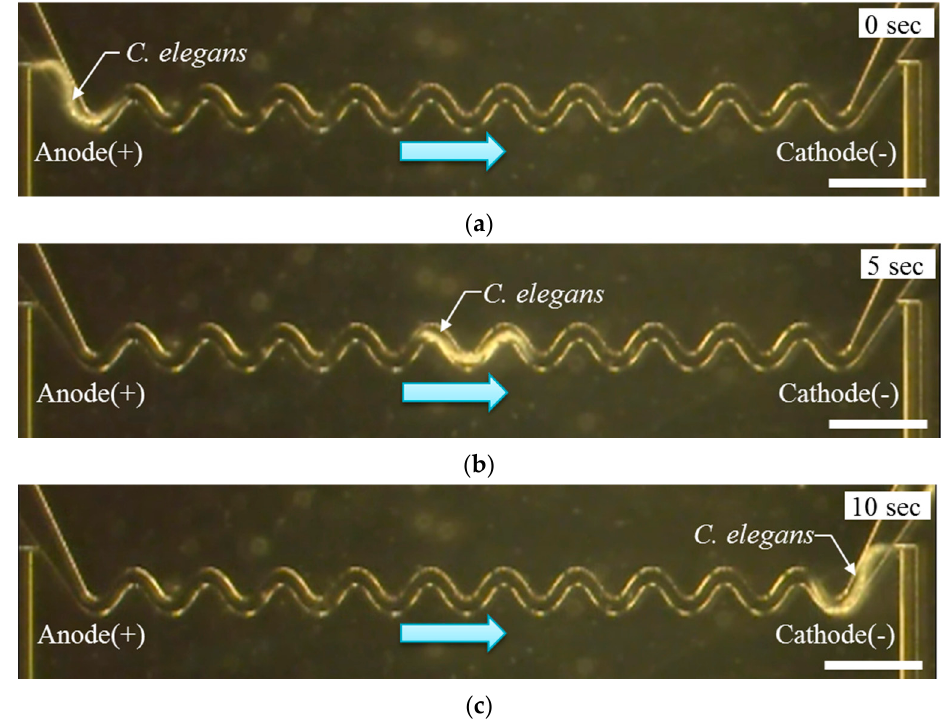
Figure 6. The measurement result of the electrical current using the micro channel. ( a – c ) Experiment result of electrotaxis over time: (a) 0 s; (b) 5 s; and (c) 10 s after applying 5 V (~2.4 V/cm). Scale bar marks 1 mm.